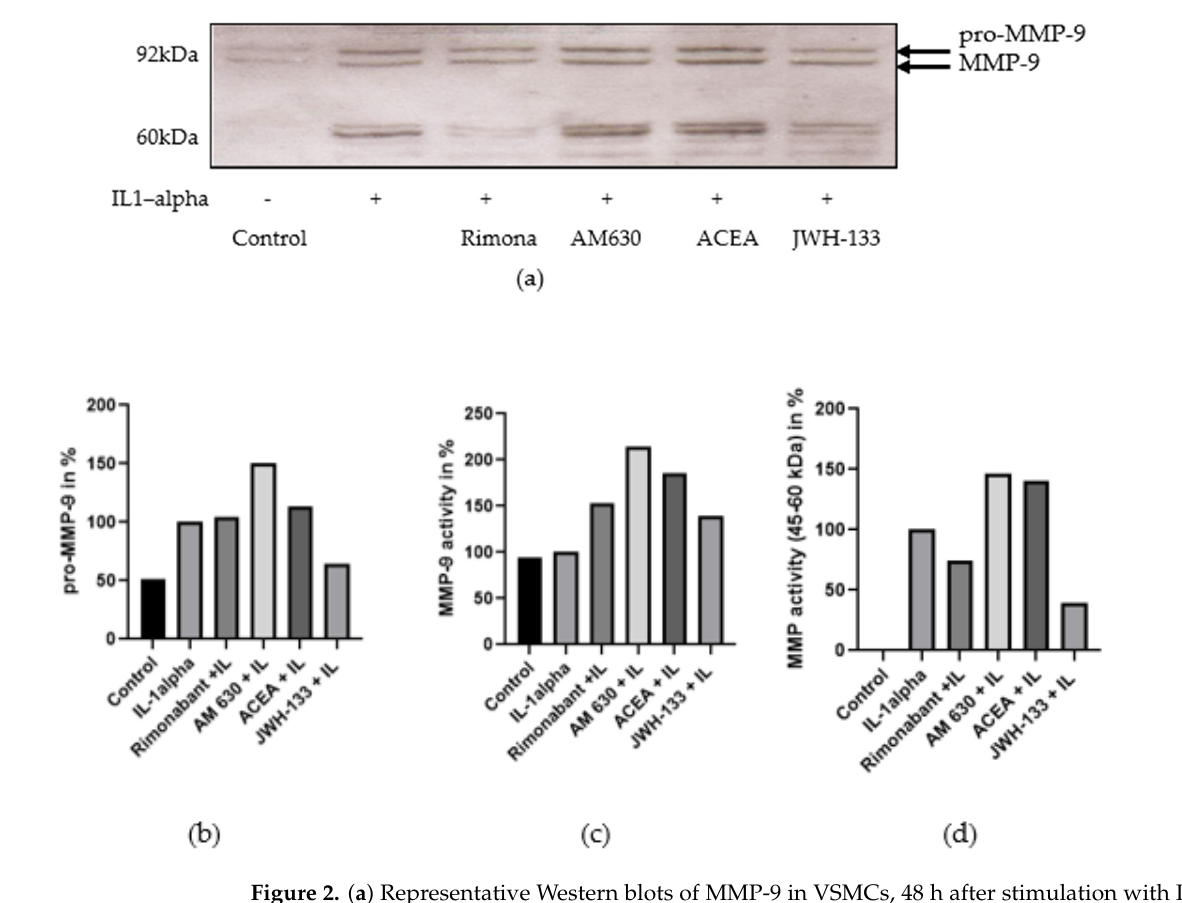
Figure 2. ( a ) Representative Western blots of MMP-9 in VSMCs, 48 h after stimulation with IL-1 α . ( b ) Densiometric analysis of proMMP-9. ( c ) Densiometric analysis of MMP-9. ( d ) Densiometric analysis of MMP (45–60 kDa).